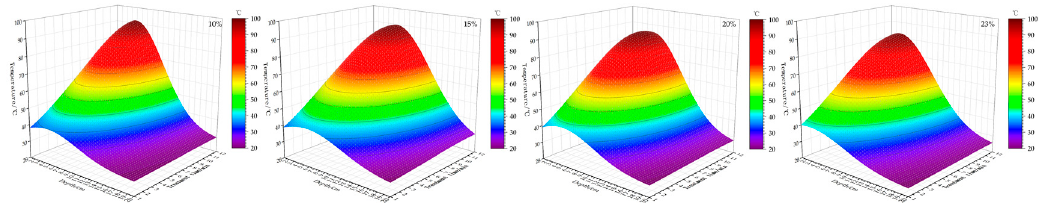
Figure 28. Fitting surface of the loess internal temperature with irradiation time and soil depth.